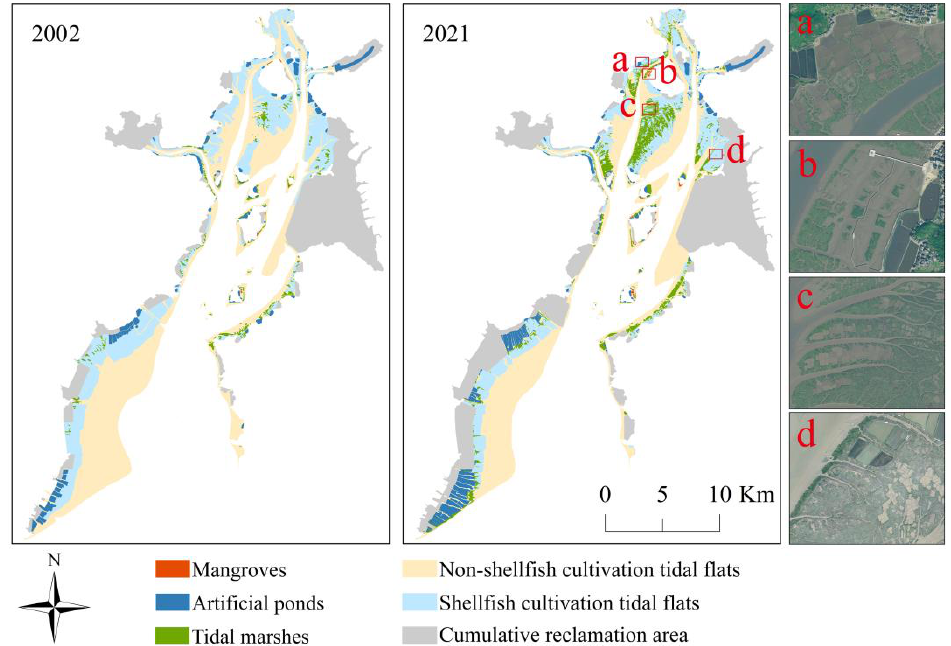
Figure 9. Distribution of shellfish cultivation, pond cultivation, and tidal marshes in 2003 and 2021. ( a ) The shellfish cultivation caused the U-shaped distribution pattern of S. alterniflora . ( b ) S. alterniflora was cleared in mangrove areas. ( c ) S. alterniflora was cleared in shellfish cultivation areas. ( d ) S. alterniflora grew again in the abandoned culture area.